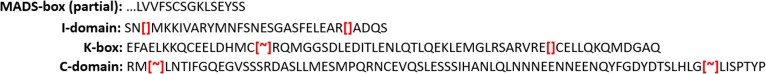
MADS-domain peptide encoded by contig 9846 along with the position of six putative introns.The peptide is divided into the four domains, with the short I-domain being indicative of a type IIc MADS domain protein. Intron position, as determined by blasting Norway and white spruce genome assemblies (S3 File), are designated by bolded red brackets, although the positions of three could not be precisely determined due to alignment anomalies ([~]). Accession KY229688.